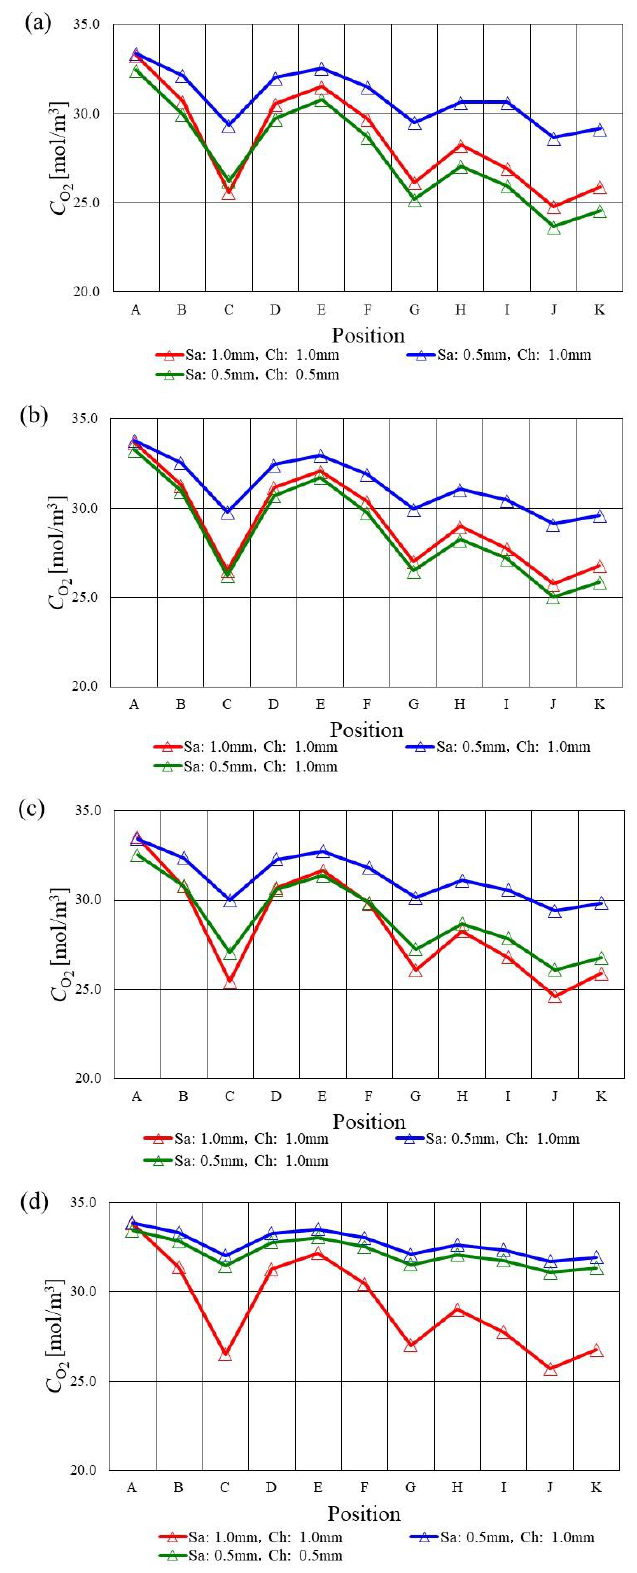
Figure 6. Molar concentration of O 2 along with the gas channel on the interface between PEM and catalyst layer at the cathode among various s.t. at T ini = 363 K. ( a ) A80%RH/C80%RH, ( b ) A80%RH/C40%RH, ( c ) A40%RH/C80%RH, ( d )